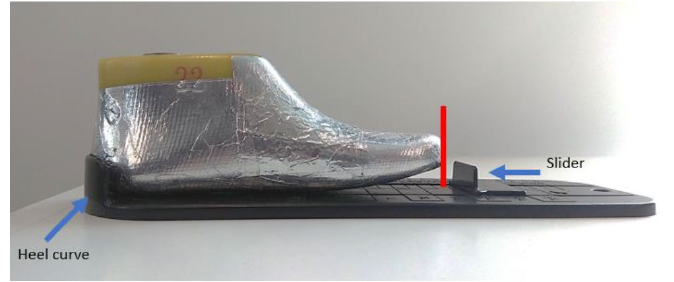
Figure 20. Bobux shoe-size measurement.